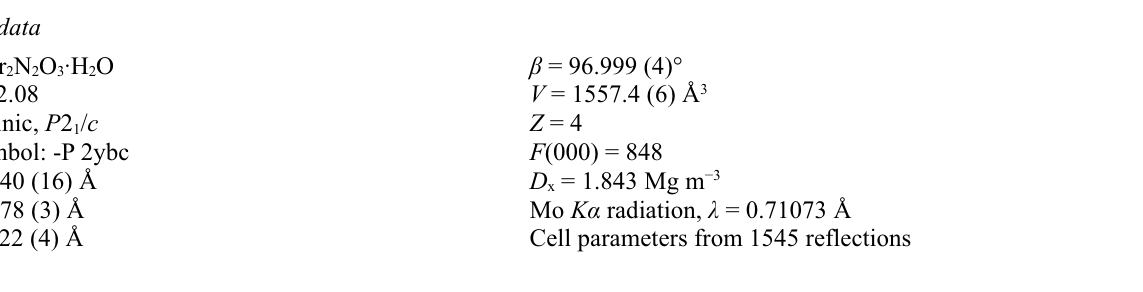
Figure 2 The molecular packing of (I), viewed along the c axis. Hydrogen bonds are drawn as dashed lines. ( E )- N ′ -(3,5-Dibromo-2-hydroxybenzylidene)-4-hydroxybenzohydrazide